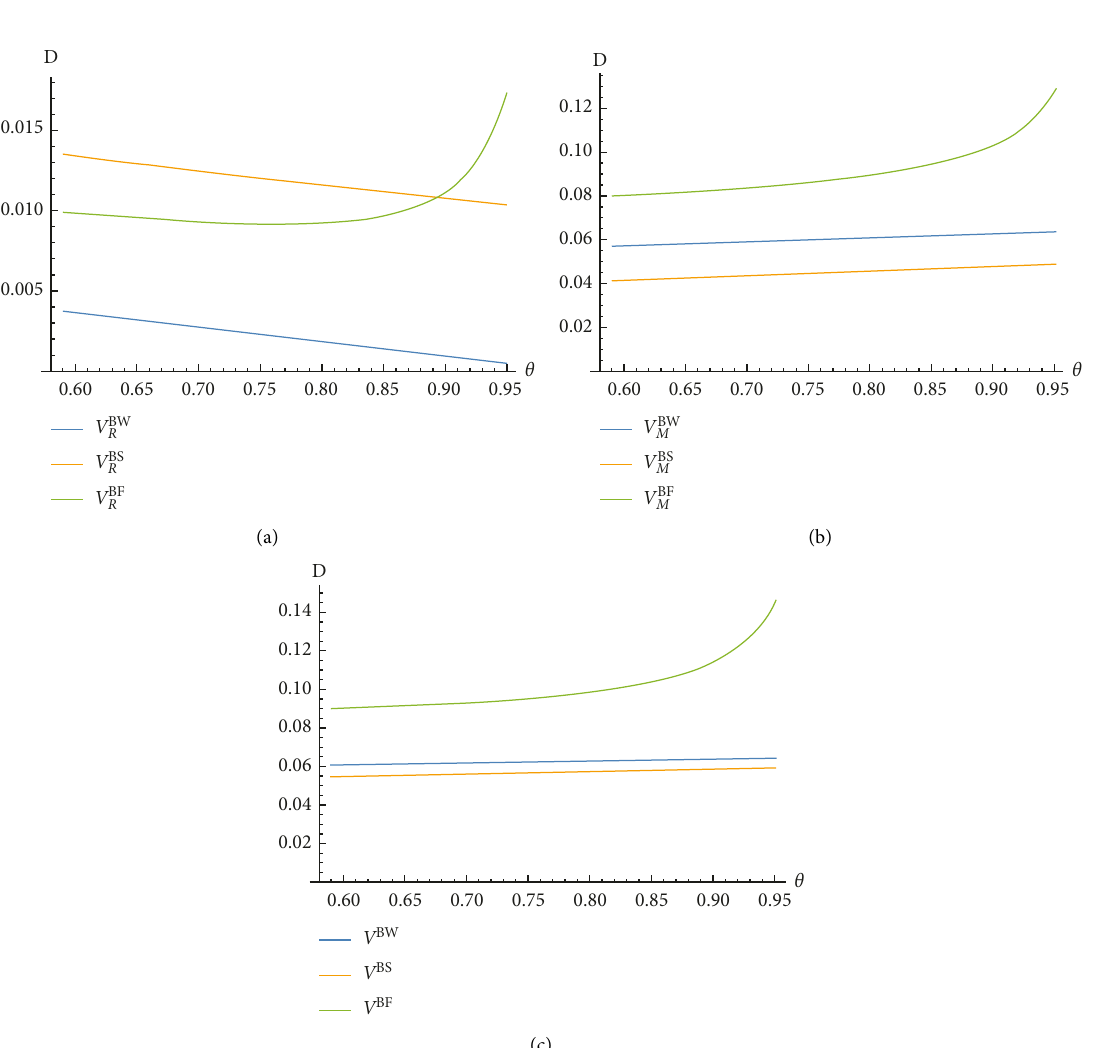
Figure 4: Profit comparison with respect to θ . (a) θ vs. V